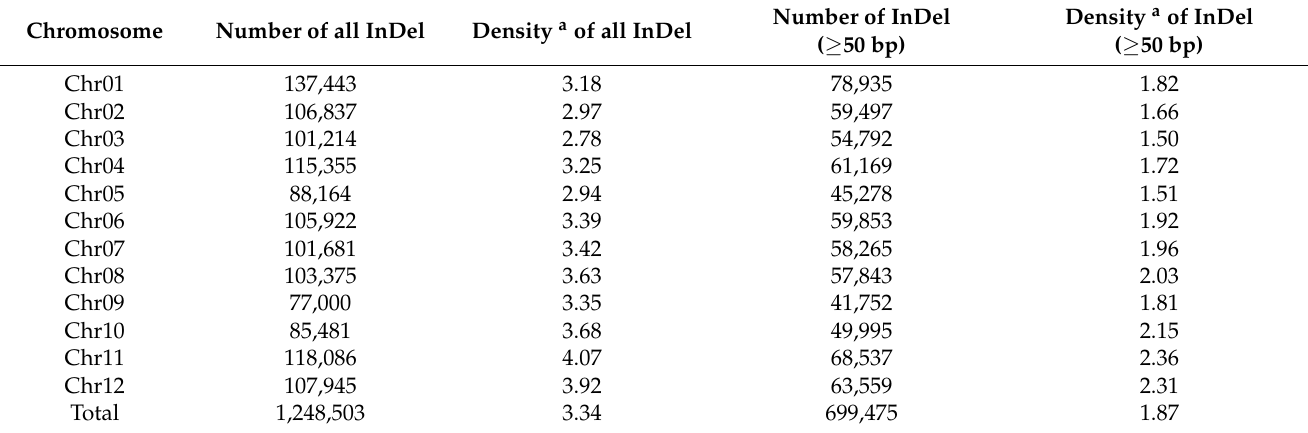
Table 1. The number of InDels compared with the reference genome (Nipponbare MSU7/IRGSP1.0). Chromosome Number of all InDel Density a of all InDel